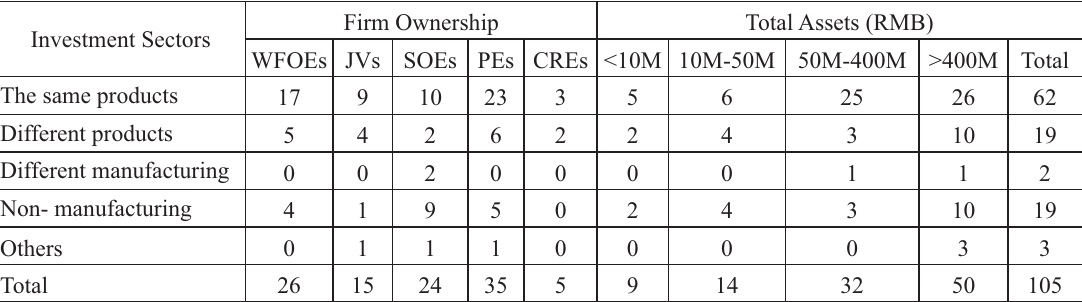
Table 6. Sector of outward